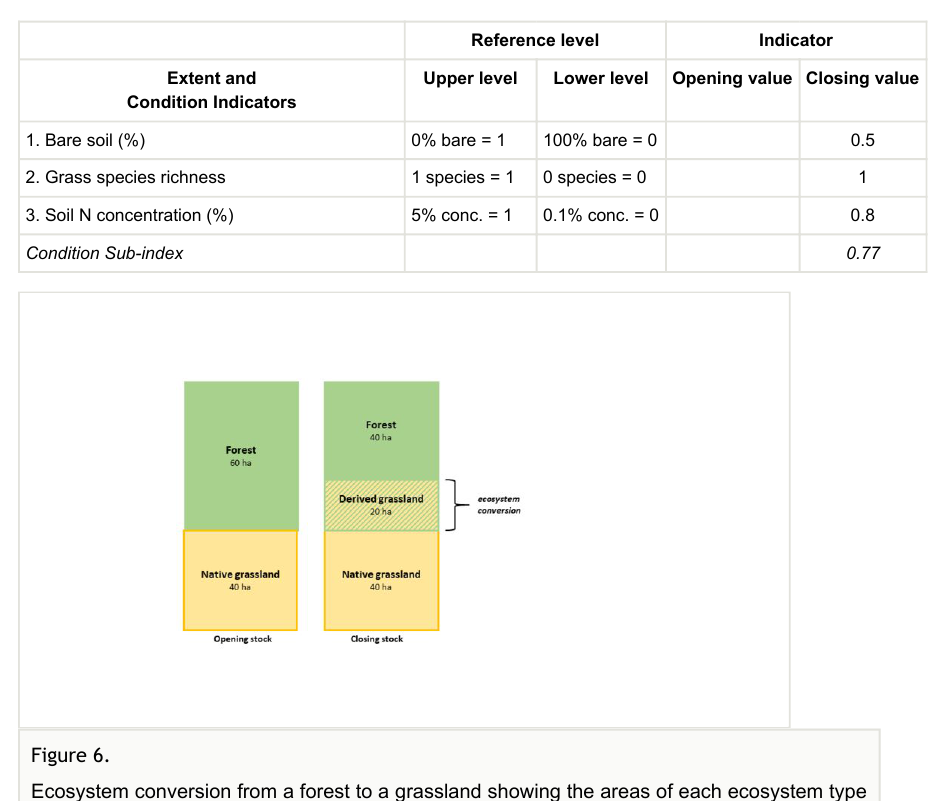
Ecosystem conversion from a forest to a grassland showing the areas of each ecosystem type at the opening and closing stocks, resulting in a change in ecosystem extent.